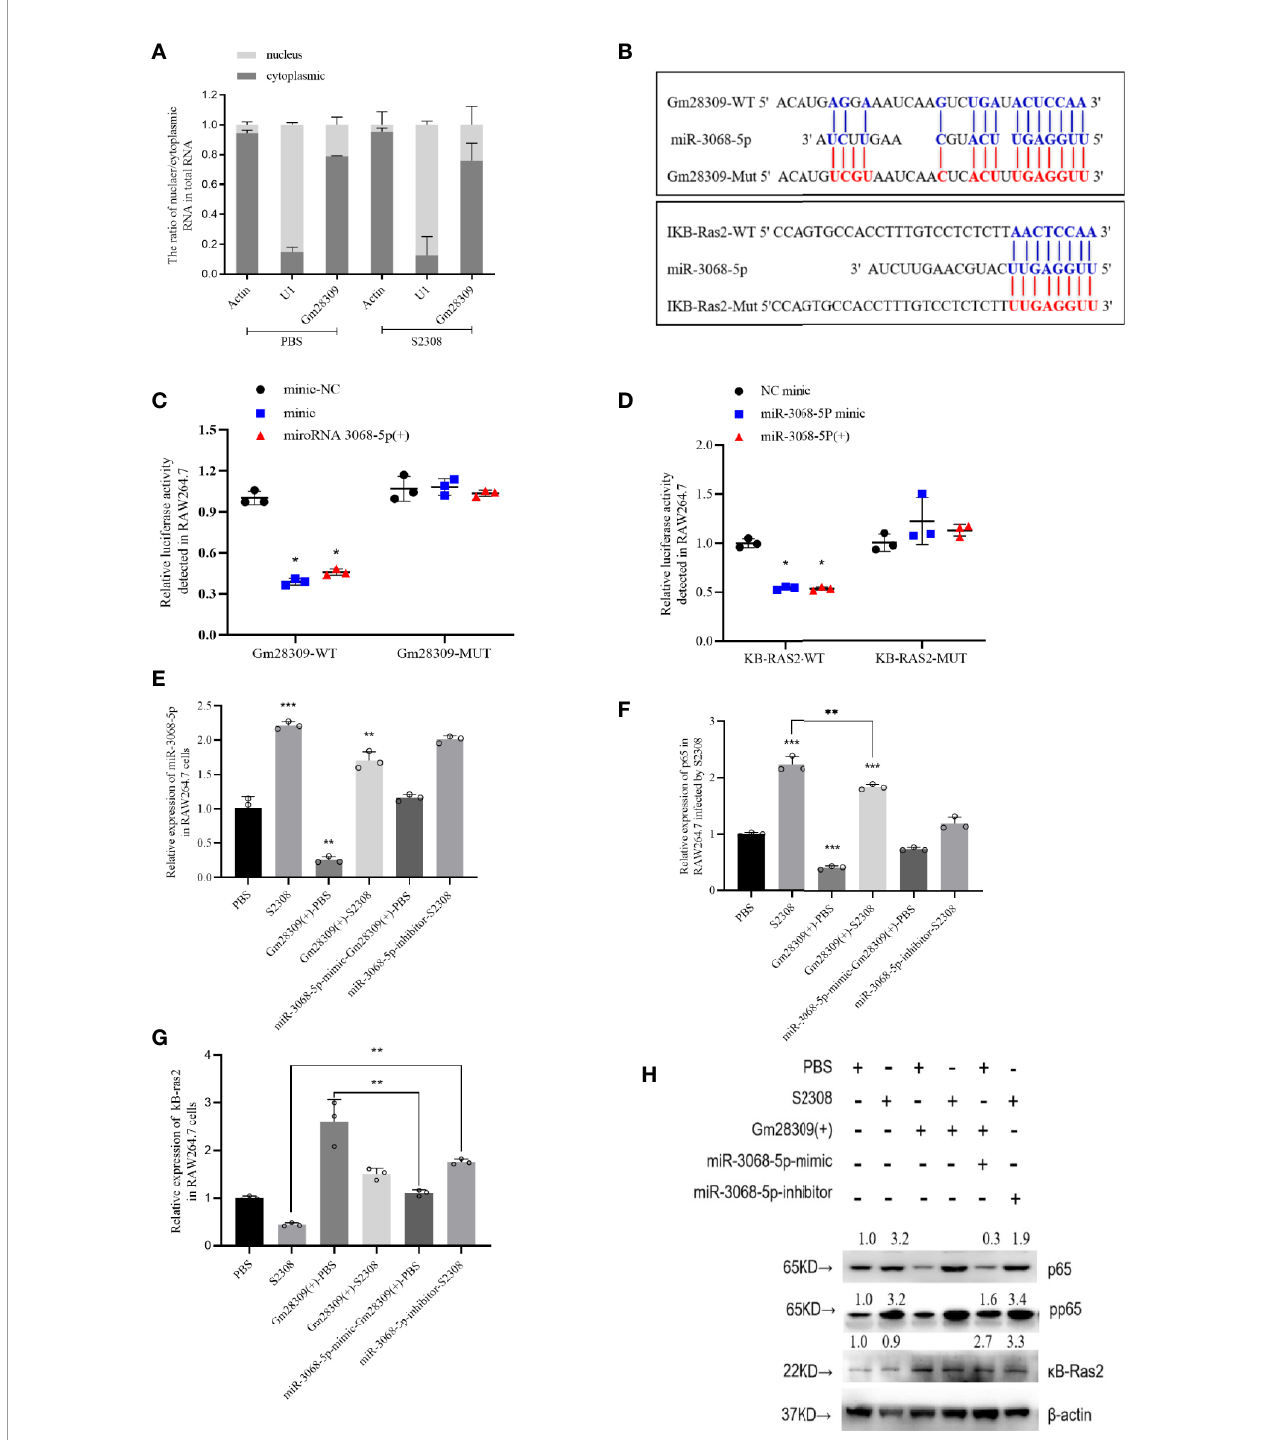
FIGURE 5 | Gm28309 sponges miR-3068-5p to repress the NF- k B signaling pathway. (A) Subcellular localization of Gm28309 as determined using qRT-PCR on subcellular fractions. (B) Predicted Gm28309 binding and mutant sites on miR-3068-5p and k B-Ras2. (C , D) Luciferase reporter assays of Gm28309 and k B-Ras2 in response to miR-3068-p5 or its mimic. (E – G) Expression of miR-3068-5p,p65 and k B-Ras2 in RAW264.7 cells treated with miR-3068-p5 mimic, inhibitor or overexpressed Gm28309 as detected using qRT-PCR. (H) Expression of k B-Ras2, p65 and its phosphorylation form in RAW264.7 cells treated with miR-3068-p5 mimic, inhibitor or overexpressed Gm28309, as determined western blotting on the NF- k B signaling pathway. Data are shown as mean ± SD (n = 3). *p < 0.05, **p < 0.01,***p < 0.001, one-tailed t-test (ordinary one way